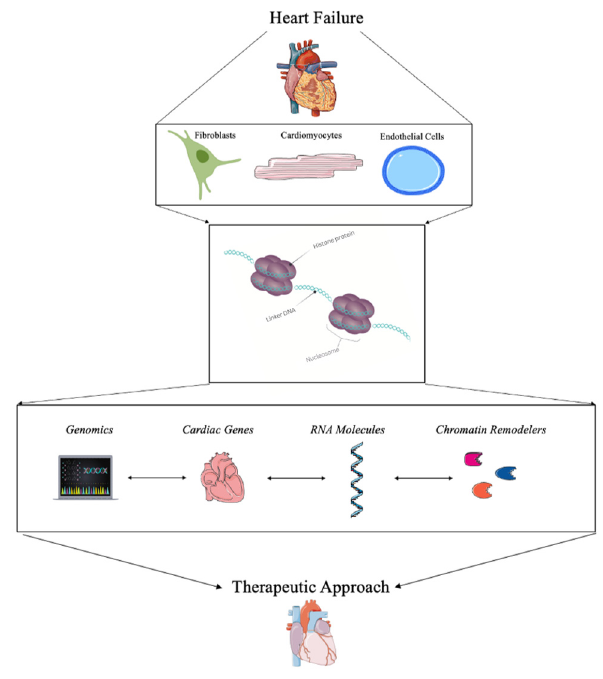
Figure 1. Summary of the role of chromatin remodeling for the treatment of heart failure.